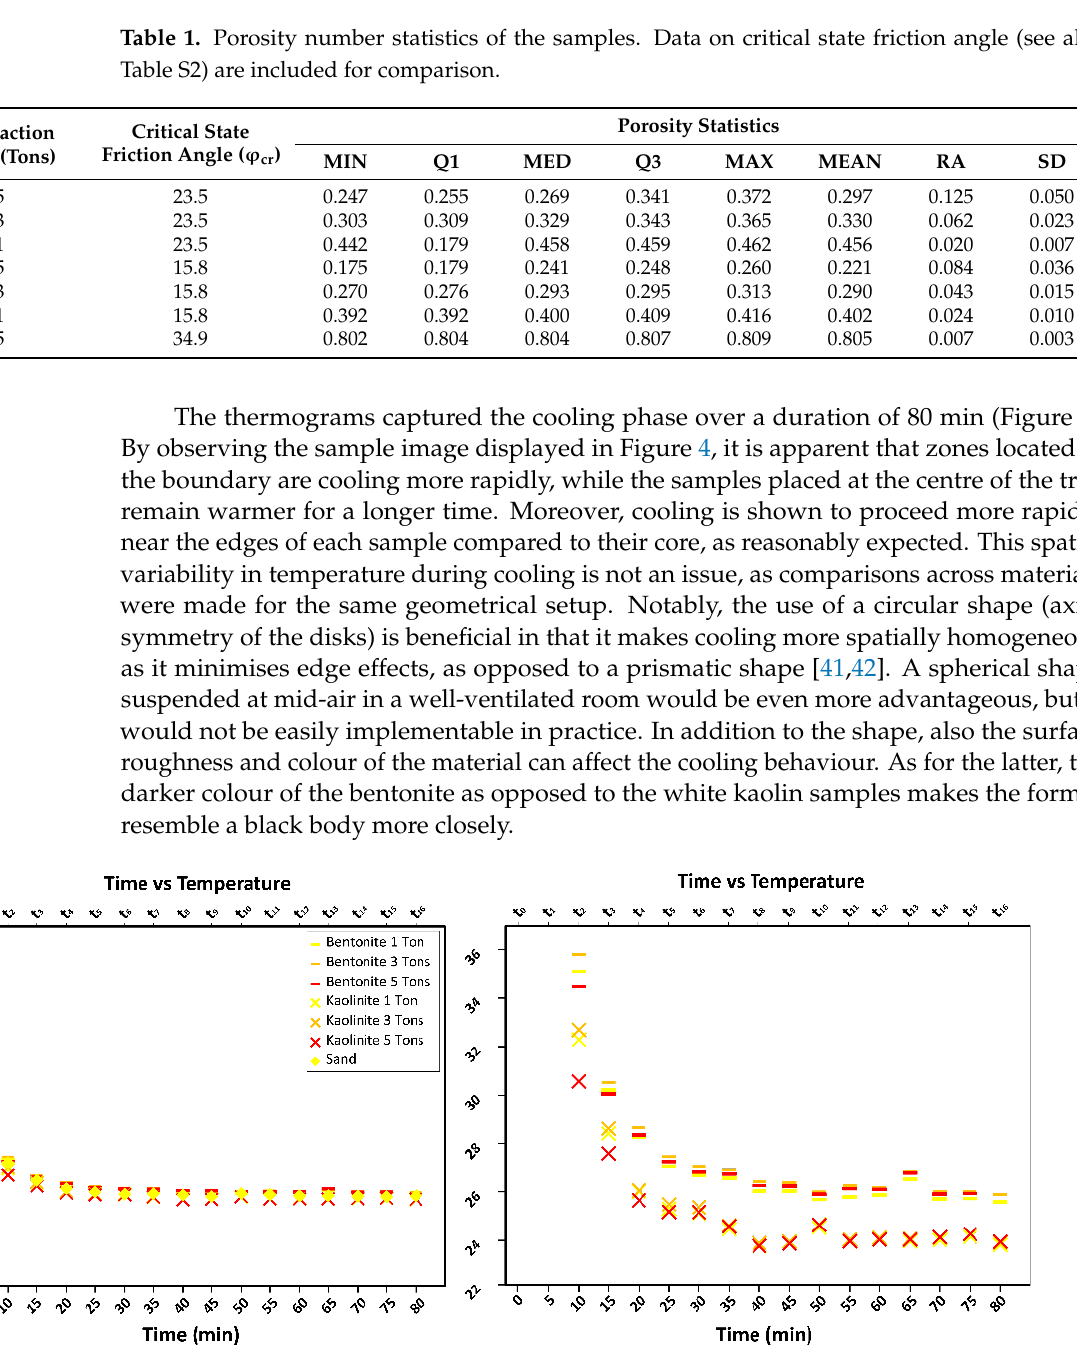
Table 1. Porosity number statistics of the samples. Data on critical state friction angle (see also Table S2) are included for comparison.